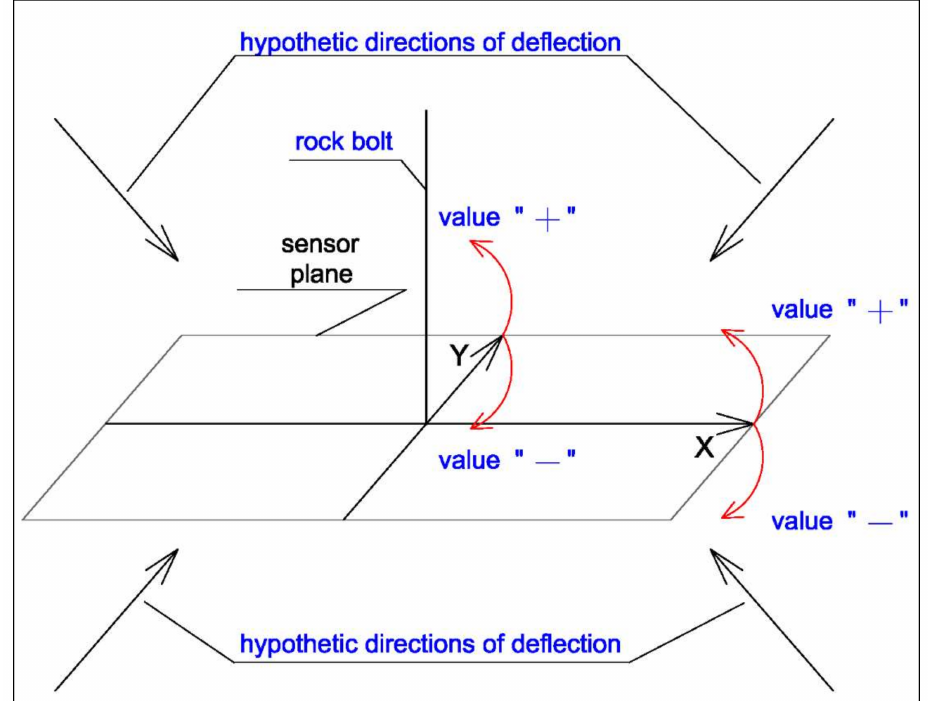
Figure 4. Operation diagram of inclinometer